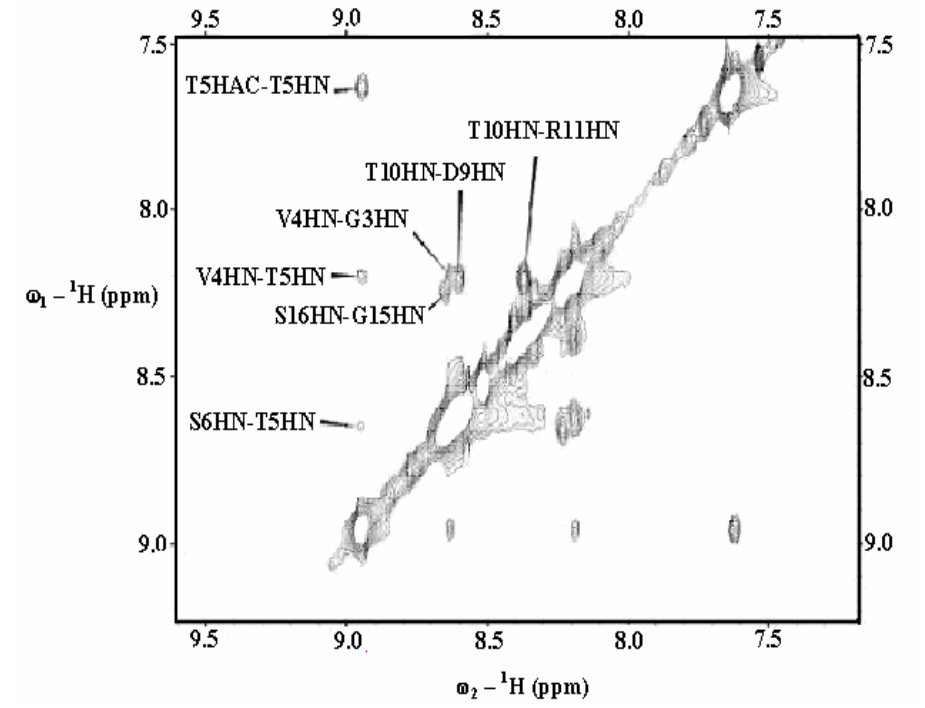
Figure 2. A section of the 200 ms NOESY spectra of the glycopeptide showing sequential amide- amide cross peaks (HN = amide proton of the amino acid residues, HAC = amide proton of the N- acetyl group in the α -GalNAc